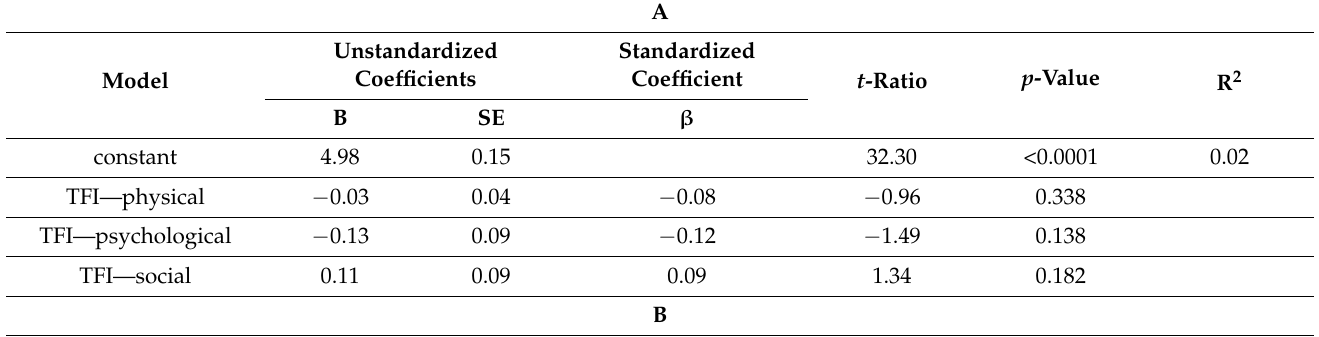
Table 5. (A) Linear regression analysis with the Hill–Bone “reduced sodium intake” variable as the dependent variable.